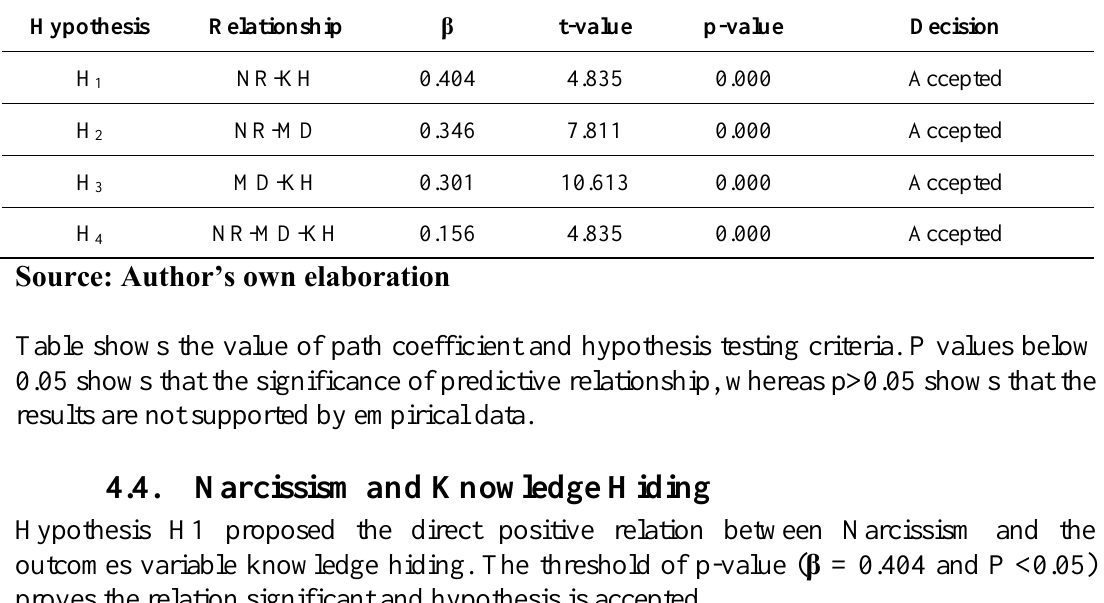
Table.7. Hypotheses Testing